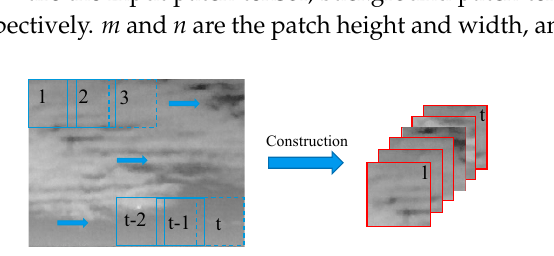
Figure 3. Illustration of tensor construction. The left is original image and the right is the constructed patch-tensor.